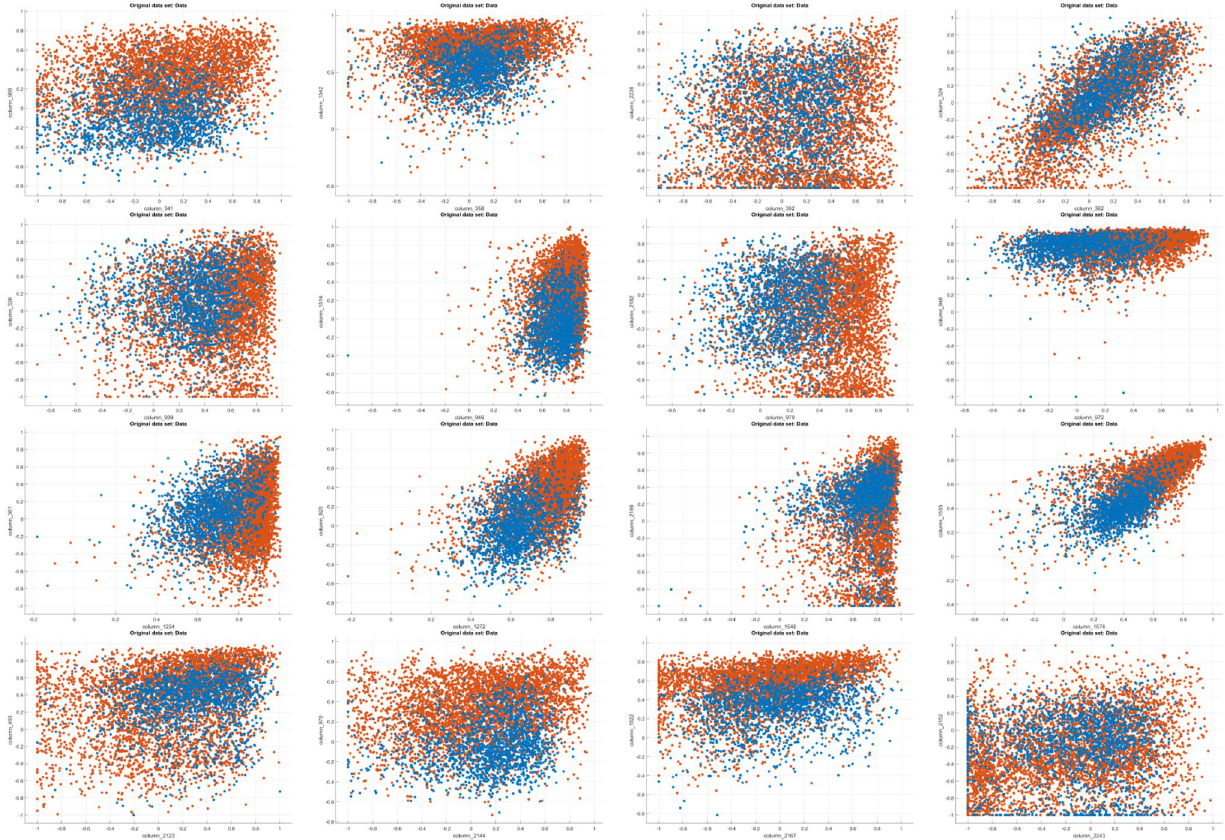
Figure 7. Scatter plots of chest X-ray data with different combinations of pixel value columns. 1 The x and y-axis of scatter plots are the column numbers out of 2500 columns in the dataset namely column 341 and column 968, column 358 and column 1542, column 392 and column 2236, column 362 and column 324, column 939 and column 326, column 946 and column 1514, column 979 and column 2182, column 972 and column 948, column 1234 and column 361, column 1272 and column 925, column 1548 and column 2198, column 1576 and column 1535, column 2123 and column 493, column 2144 and column 970, column 2167 and column 1522, column 2243 and column 2152